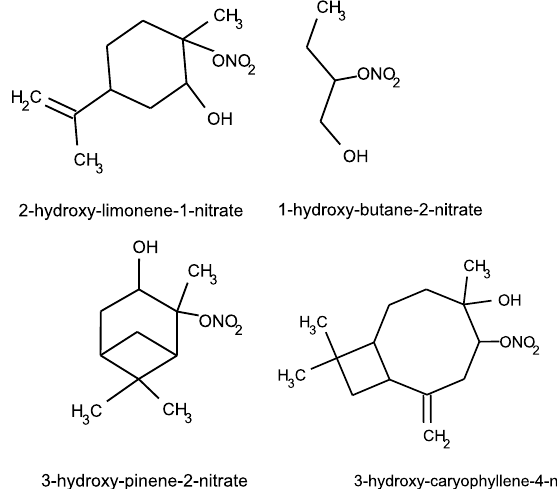
Fig. 1. One isomer of each each standard synthesized for this study.